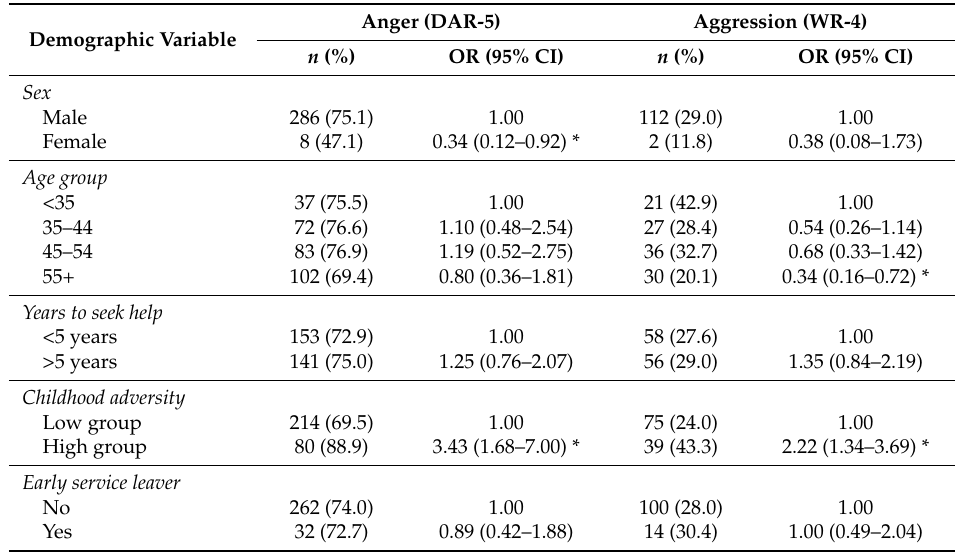
Table 1. Factors associated with anger and aggression.